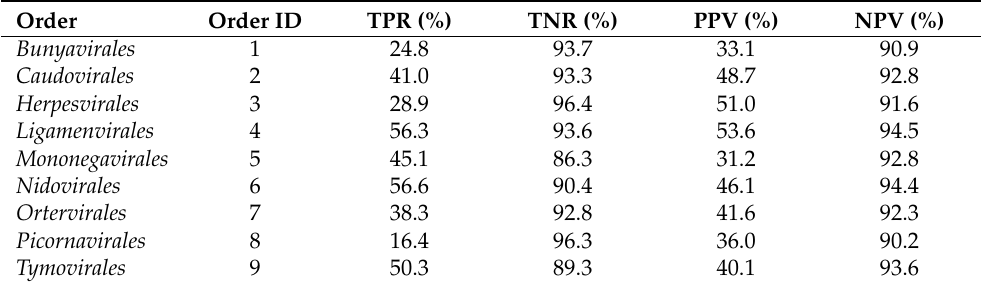
Table 5. Measures of classification performance. True positive and true negative rates (TPR and TNR) as well as positive and negative predictive values (PPV and NPV) are reported as mean values from 10 simulation runs, after summarizing classification results in a binary form (i.e., order j versus all other orders).